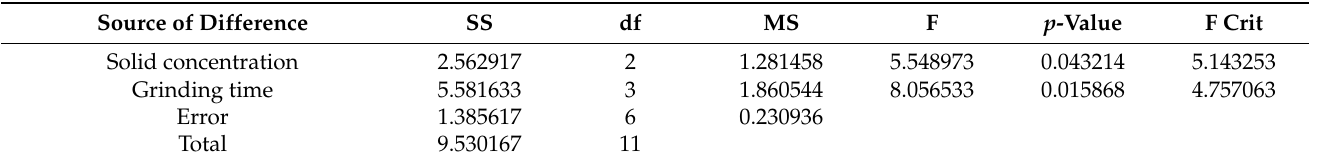
Table 3. Two-way ANOVA results for solid concentration of GBM slurry and grinding time of CG